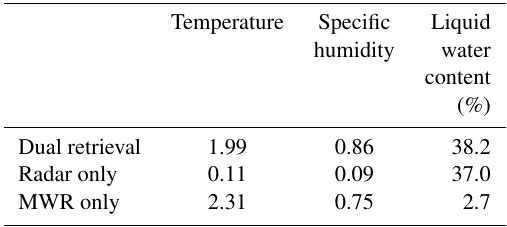
Table 3. Average DFS for temperature, humidity and LWC re- trievals between the surface and